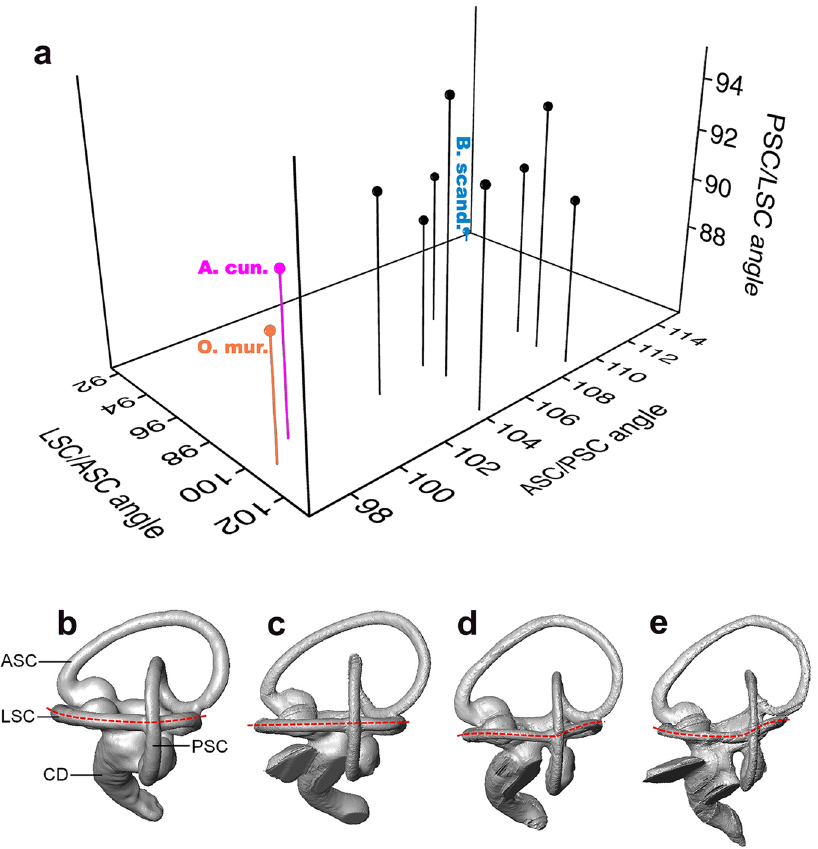
Figure 6. ( a ) 3D scatter plot of the three angles between the three semi-circular canals, in the 11 owls, showing the position of O. murivorus (in orange) near A. cunicularia (in pink). At the opposite relative to the concentrated positions of the other eight owls is B. scandiacus (in blue). ( b )–( e ) four 3D view of the inner ear of: ( b ) O. murivorus ; c , O. sunia ; ( d ) A. cunicularia ; ( e ) B. zeylonensis , showing the sinuosity of LSC (dashed red line). ASC, anterior semi-circular canal; CD, cochlear duct; LSC, lateral semi-circular canal; PSC, posterior semi-circular canal. Not to